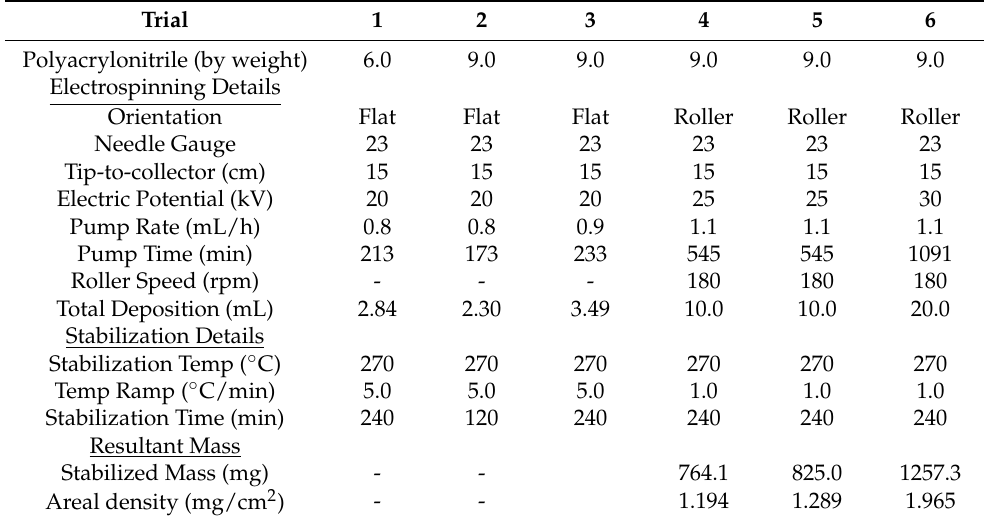
Table 2. Summary of solution, electrospinning, and stabilization parameters.